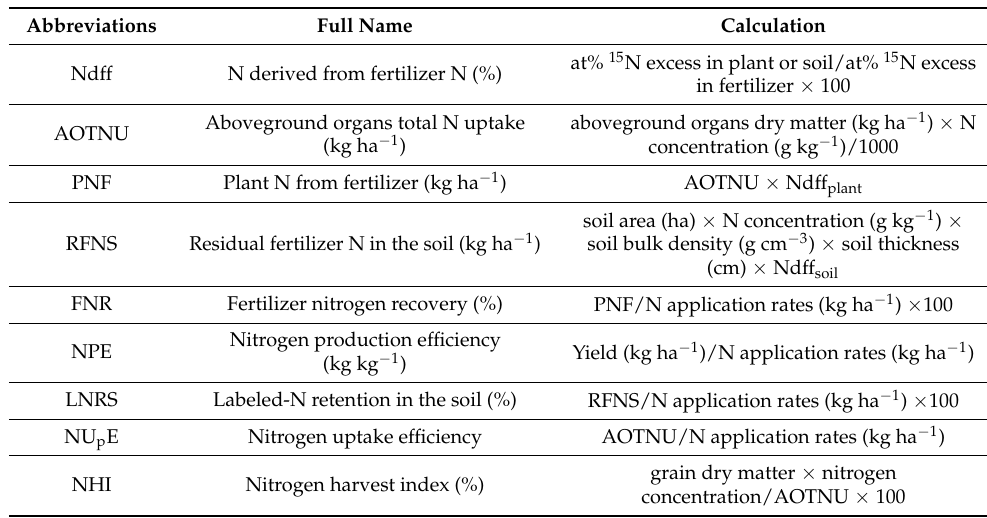
Table 3. 15 N calculations and tracer